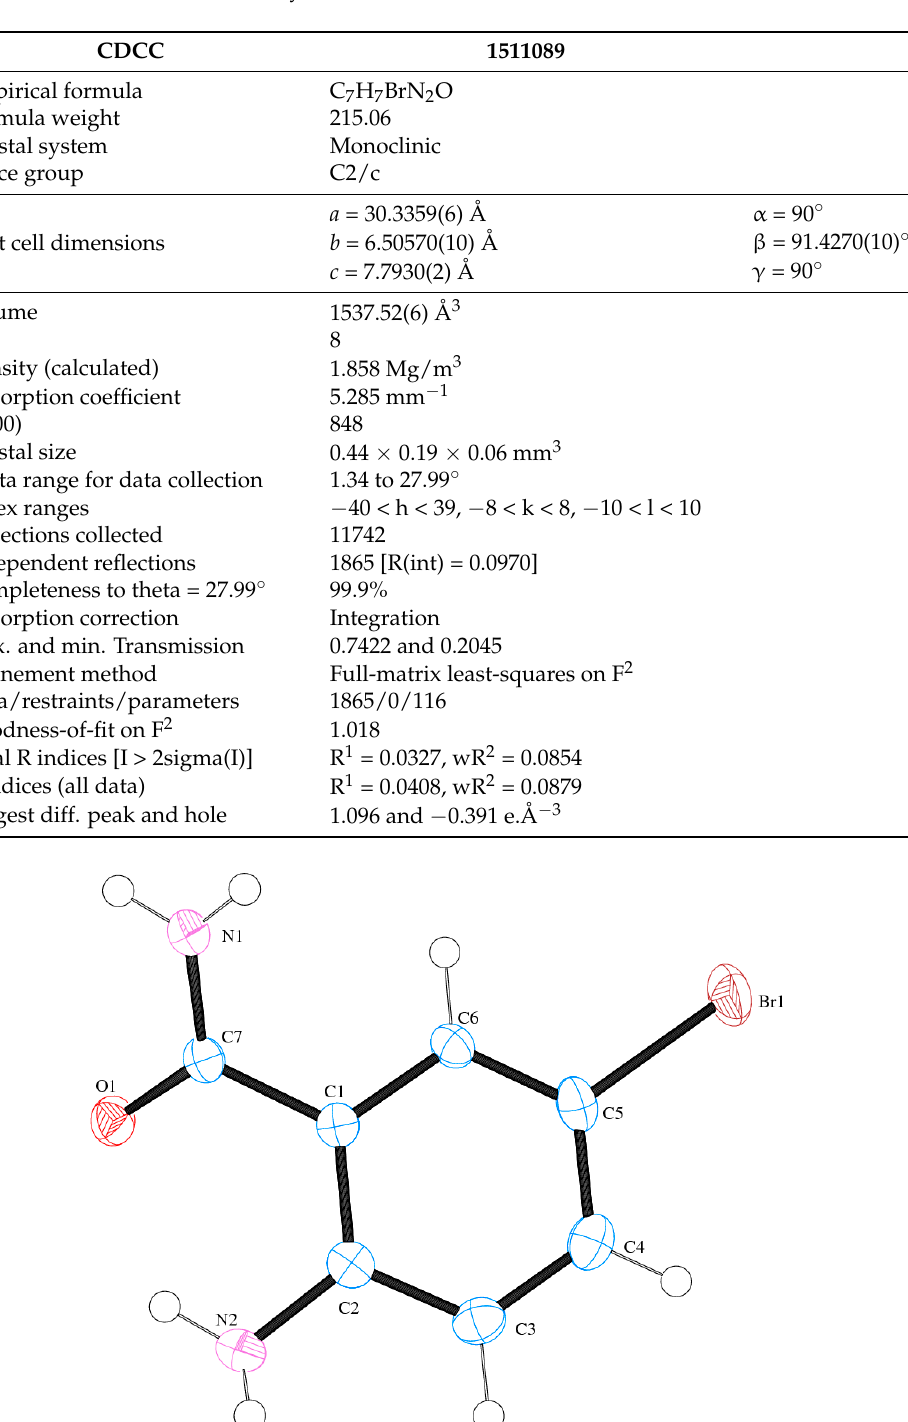
Table 5. The crystal data and structure refinement for ABB .